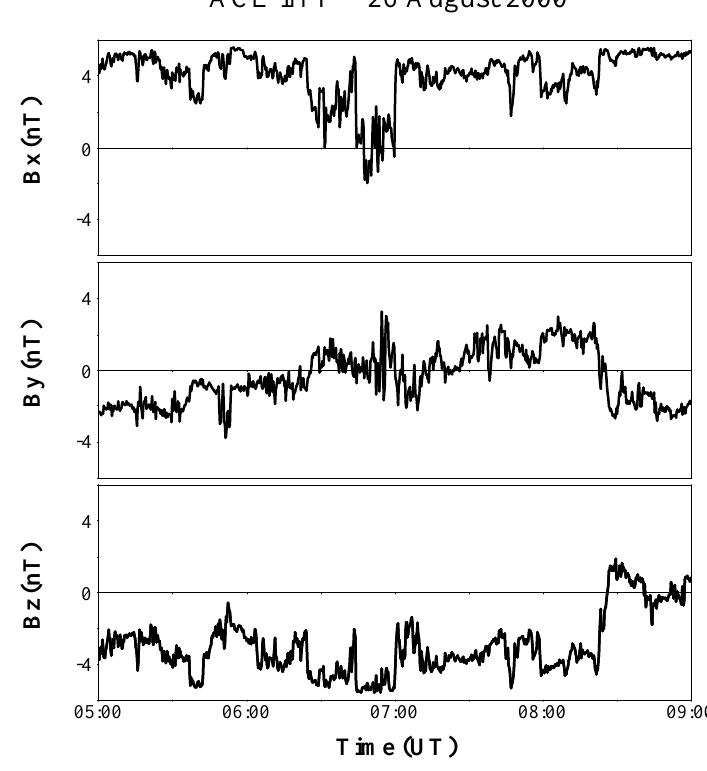
Fig. 1. The three components of the IMF measured by the ACE spacecraft upstream in the solar wind between 05:00–09:00 UT on 26 August